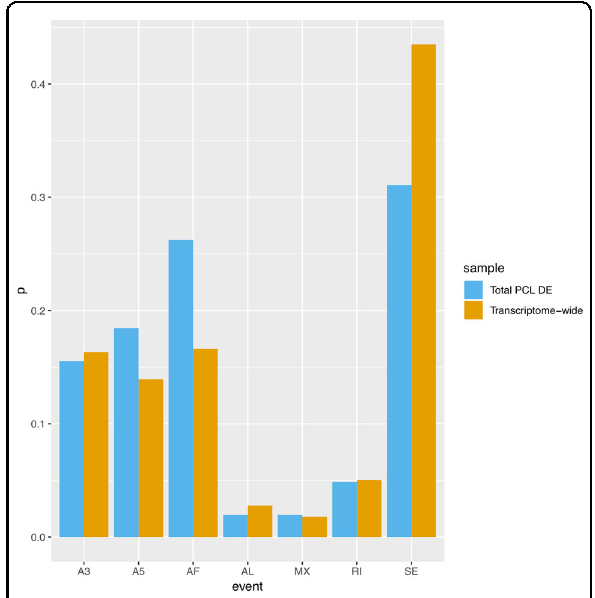
Fig. 1 Bar graph comparing the proportions of signi fi cant AS events associated with total PCL to the transcriptome-wide proportions of AS events detected by SUPPA. A3 alternative 3 ’ splice sites, A5 alternative 5 ’ splice sites, AF alternative fi rst exons, AL alternative last exons, MX autually exclusive exons, RI retained introns, SE skipping